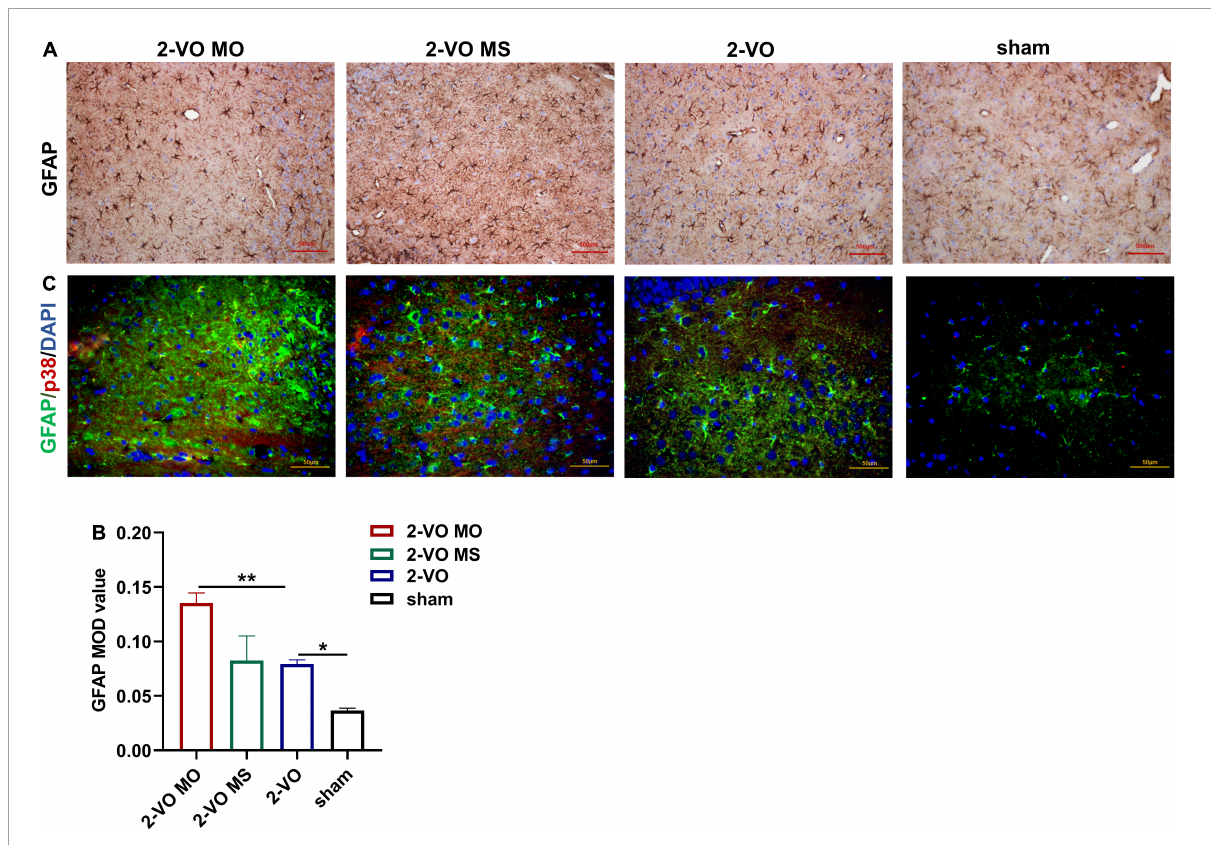
FIGURE7 Effects of molar loss on GFAP in the rat hippocampus. (A,B) IHC staining showed the expression of GFAP (IHC, × 200, n = 4, MOD values are expressed as mean ± SD, * p < 0.05, ** p < 0.01). (C) Double immunofluorescent staining revealed colocalization of GFAP (green) and p38MAPK (red) proteins in the rat hippocampus, and the nuclei were in blue (magnification ×